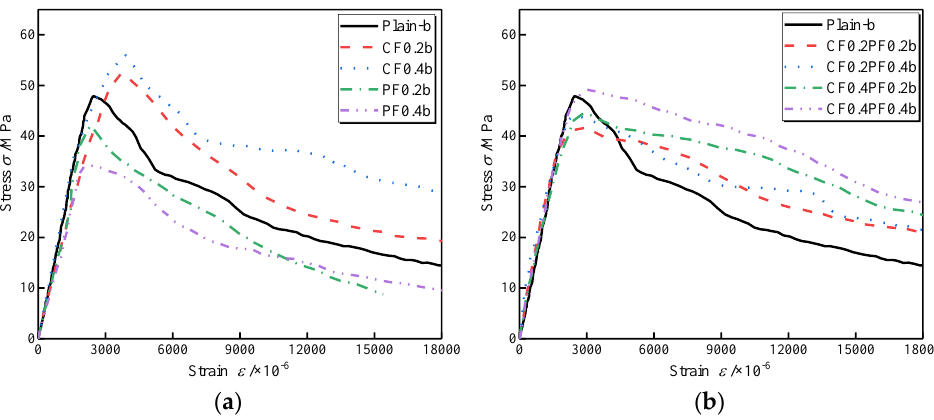
Figure 5. Effects of CF and PF on the compressive stress – strain curves of LWAC (W/B = 0.3): ( a ) fibers in single form; ( b ) fibers in hybrid form.